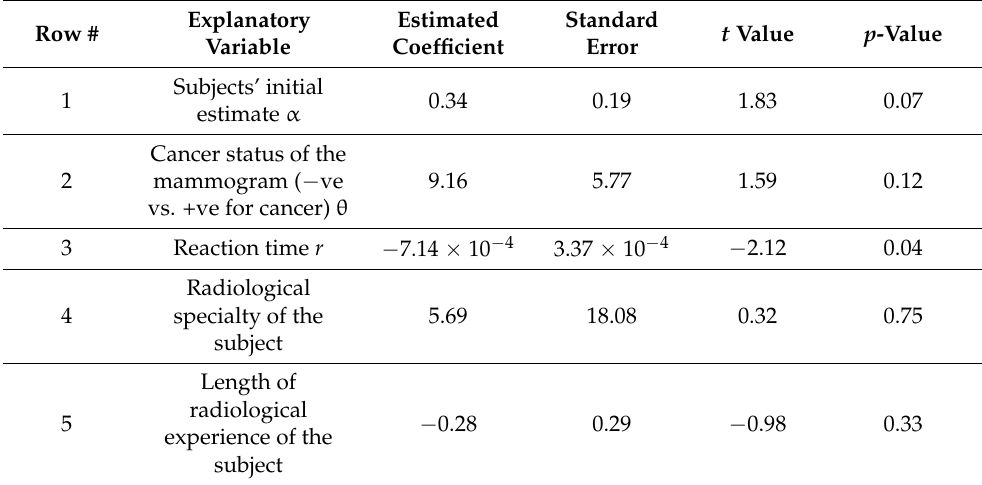
Table 4. Contribution of the various explanatory variables to the final estimates γ when anchoring information was unavailable in Study 2 (conditions 3 and